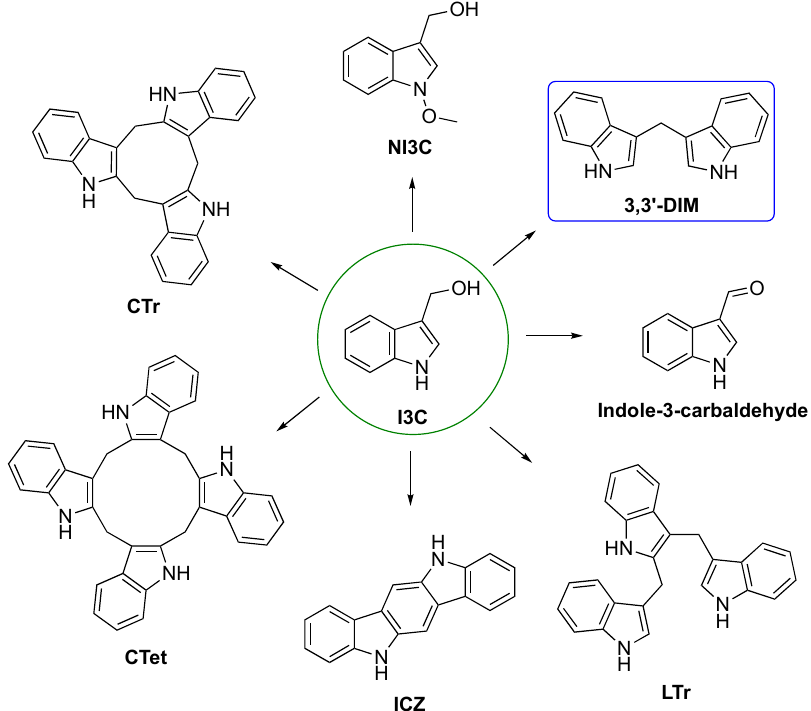
Figure 4. Chemical structures of the main biosynthetic oligomer compounds derived from I3C. 3,3 (cid:48) -DIM is in a box because it is the major and most studied I3C metabolite. Other interesting derivatives are DIM substituted with dimethyl groups in different positions, such as 1,1 (cid:48) , 2,2 (cid:48) , 5,5 (cid:48) , 6,6 (cid:48) , 7,7 (cid:48) , or tetramethyl (1,1 (cid:48) ,2,2 (cid:48) ) [155] (Figure 5).